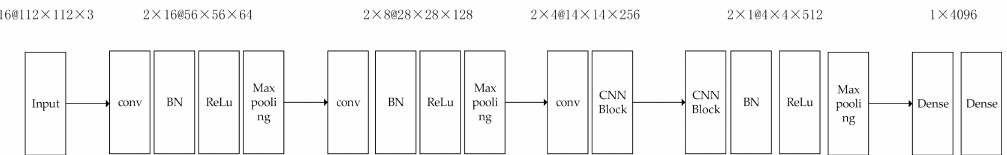
Figure 4. The architecture of the model, the size of the feature map and the number of channels is marked in the figure. Since we are using a parallel network, the number of channels needs to be multiplied by two.